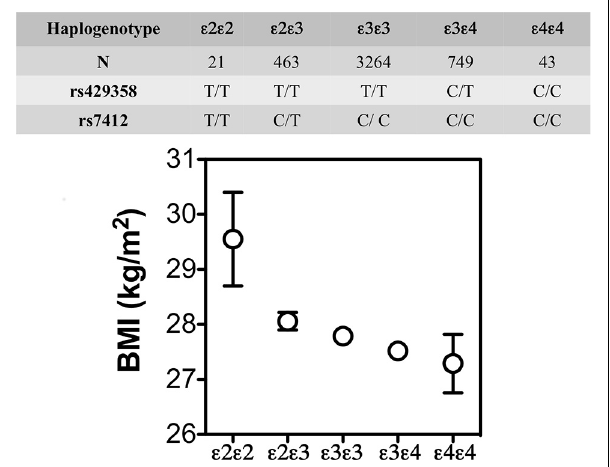
FIGURE 4 | BMI (mean ± SE) by APOE isoforms. In the Spanish Aragon Workers Health Study ( n = 4,881) APOE isoforms were associated with body mass index (BMI) in rank order of APOE4 < APOE3 < APOE2. APOE2/E2 carriers ( n = 21) had a greater BMI than the other isoforms. Adapted from Tejedor et al.